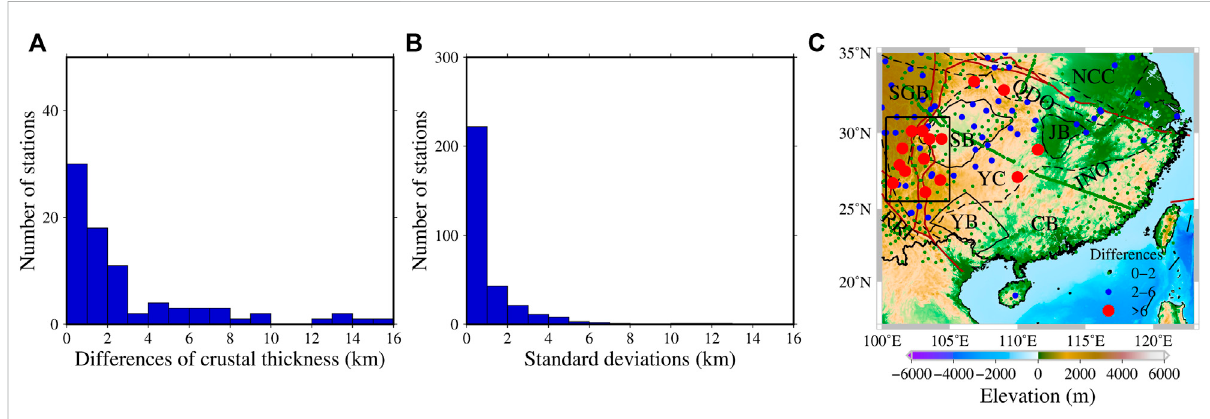
FIGURE 4 Uncertainties of crustal thicknesses determined from receiver function analysis. (A) Differences in crustal thickness for stations with two different estimates. (B) Standard deviations of crustal thickness for stations with three or more different estimates. (C) Distribution of estimates for those stations with large differences.